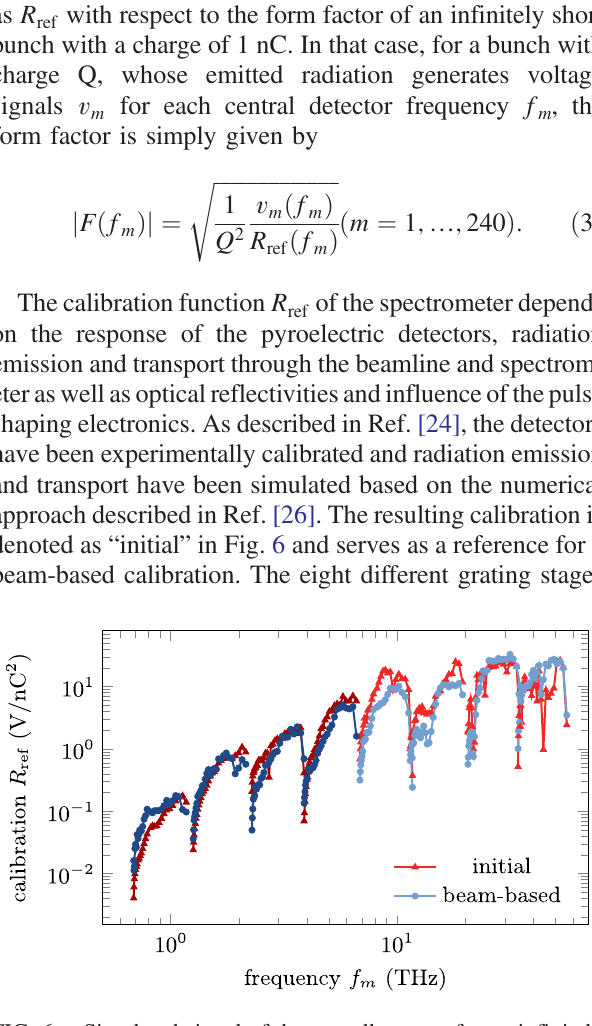
FIG. 7. Form factor of the spectrometer using the initial calibration and calibration after the beam-based correction. The initial calibration was adapted to reproduce the form factor from the comparative TDS measurement up to 30